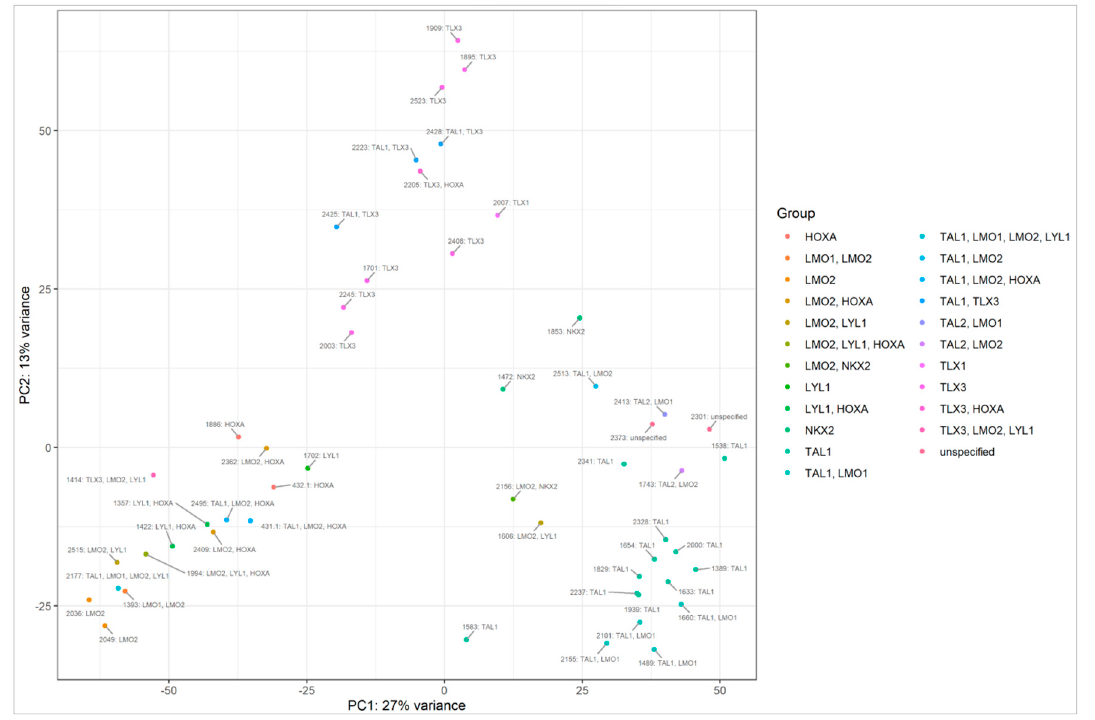
Figure A3. PCA plot based on mRNA sequencing presenting patients, classified into genetic subtypes, grouping into clusters. Cluster C3 is mainly composed of samples classified into the TAL1 subtype, and it includes all three samples showing NKX2 expression. Cluster C2 is mainly composed of samples from the TLX3 subtype, while cluster C1 is enriched in LMO1 , LMO2 , LYL1 and HOXA cases. miRNAs differentially expressed between clusters C1, C2, C3, enriched in specific genetic subtypes are presented in Table S3.